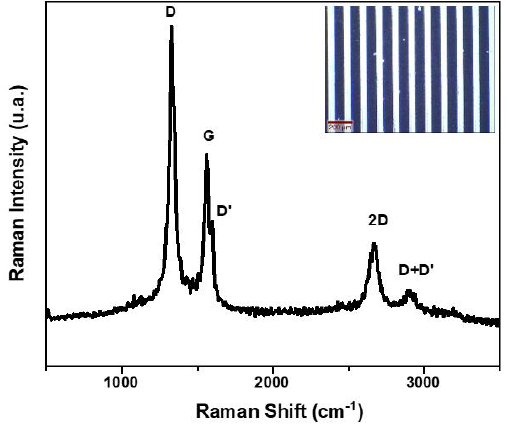
Figure 5. Raman spectrum of vertical graphene.